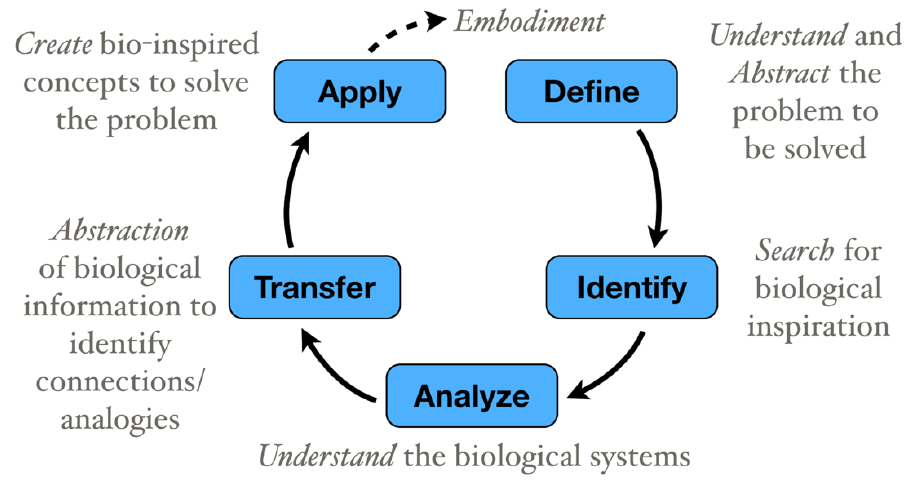
Figure 1. Generic Bio-inspired Design Process.